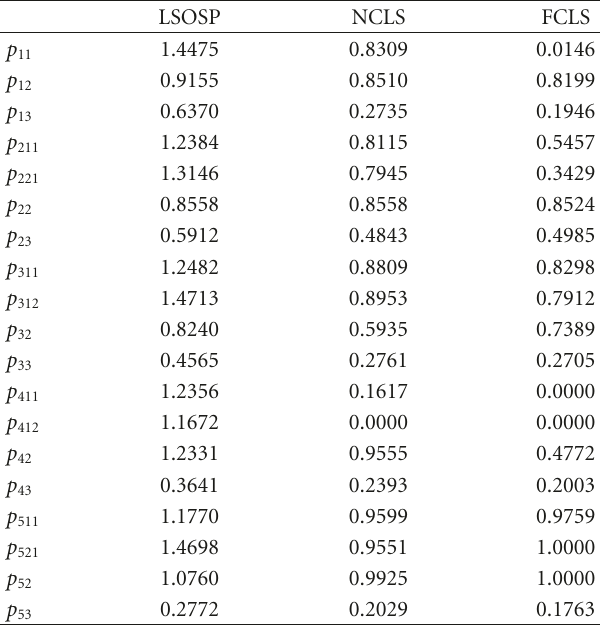
Table 4: Abundance fractions of 19 panel pixels in Figures 27(a)– 27(c) estimated by LSOSP, NCLS, and FCLS.